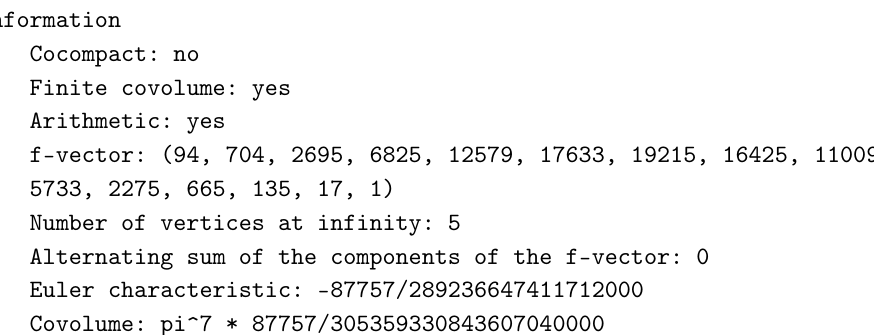
Figure 5. Vinberg’s hyperbolic lattice Γ 14 ⊂ Isom H 14 .